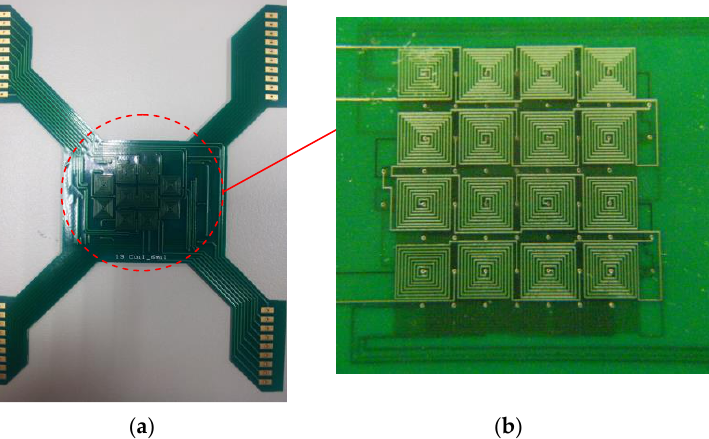
Figure 2. ( a ) Photograph of the magnetic-actuated chip. ( b ) Two-layer 4 × 4 array micro-coils of the PCB layout on the upper and bottom layers.